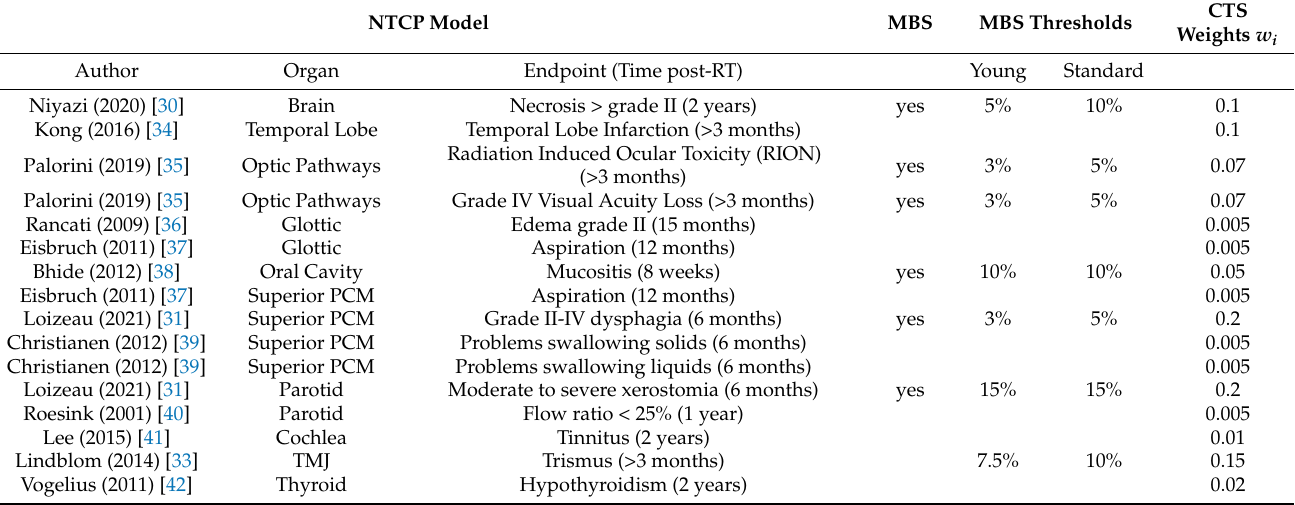
Table 1. Details of the NTCP models set, MBS threshold values and CTS weights. For the 7 models selected for MBS analysis, corresponding threshold values. CTS weights were defined following a clinical rationale. In particular, the degree of impact on the patient QOL for a specific toxicity translate to a higher relative weight. Weight values sum up to unity. Dysphagia, xerostomia, and trismus yielded the higher relative weight values. NTCP models referring to similar endpoints had a small relative value